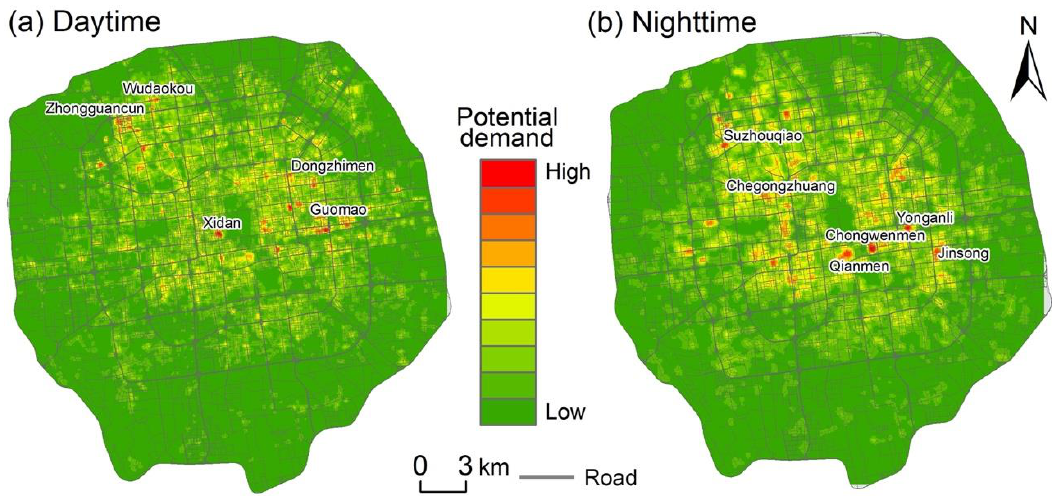
Figure 2. Spatial distribution of the potential demand for emergency services at different times : ( a ) daytime and ( b ) nighttime.